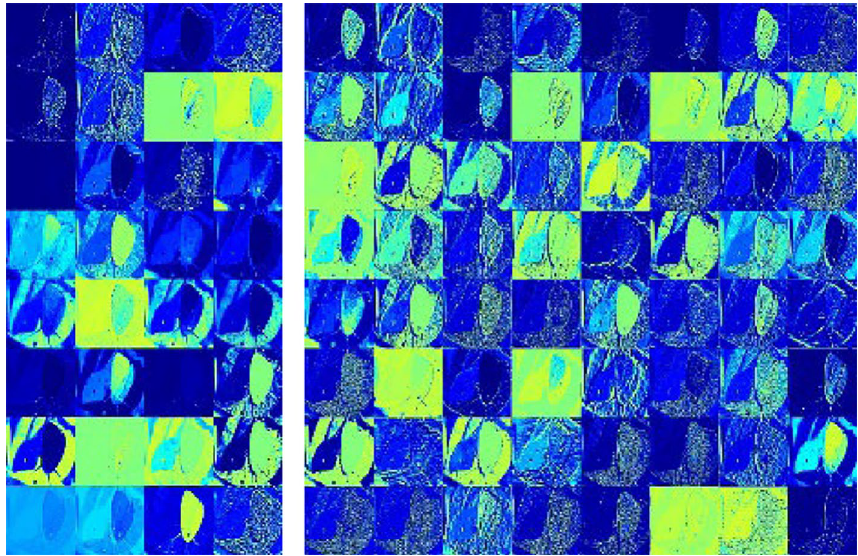
Figure 13. Feature visualization results (First layer and second layer). Note : The brighter the pixel, the higher the attention.